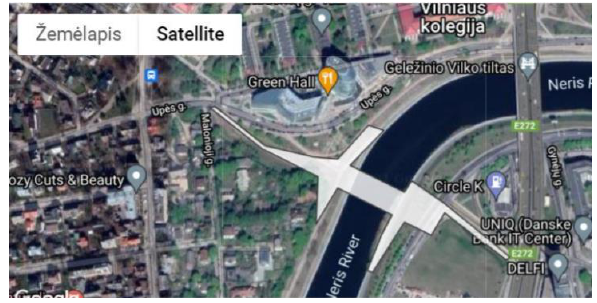
Figure 2. Dislocation of new bridge over the river Neris (Vilnius, Lithuania).